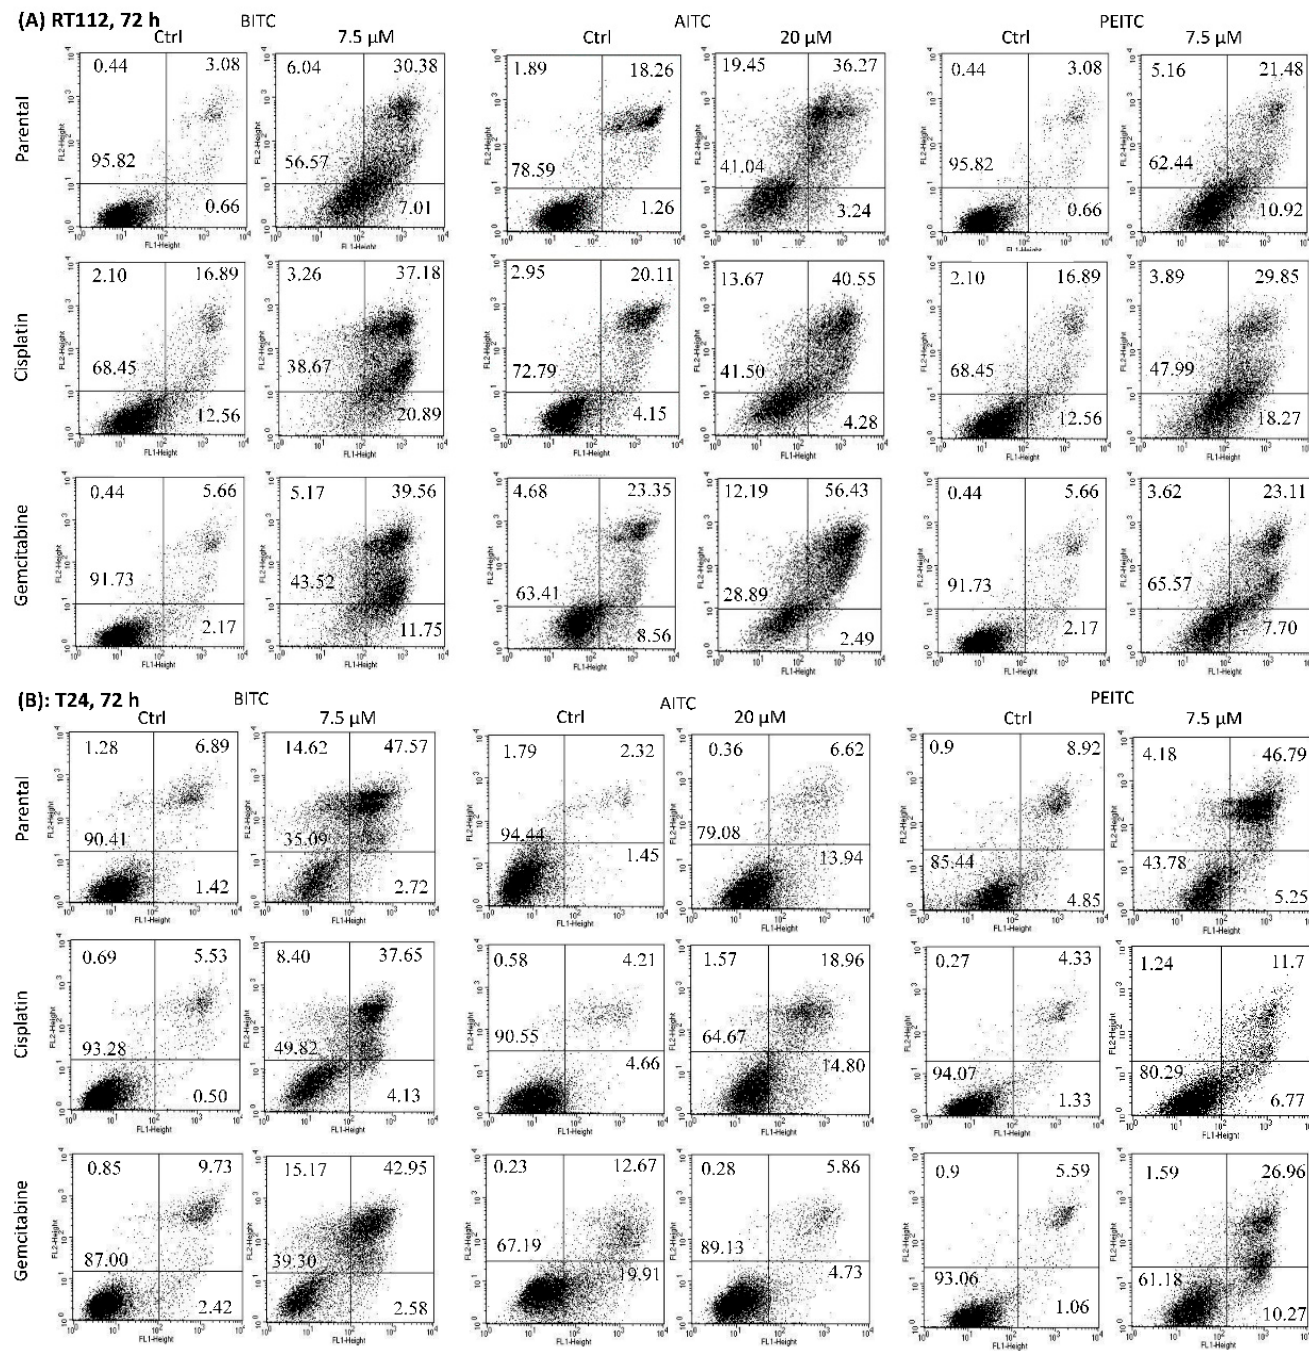
Figure 4. Early apoptosis, late apoptosis and necrosis of parental and resistant RT112 ( A ) and T24 cells ( B ) treated with BITC, AITC or PEITC for 72 h. Controls (Ctrl) remained untreated. Upper left quadrants show the percentage of cells in necrosis, upper right quadrants show the percentage of cells in late apoptosis, lower right quadrants show the percentage of cells in early apoptosis and lower left quadrants vital cells (one representative of 3 analyses; SD intra-assay < 10%). A total of 10,000 events were collected for each sample.